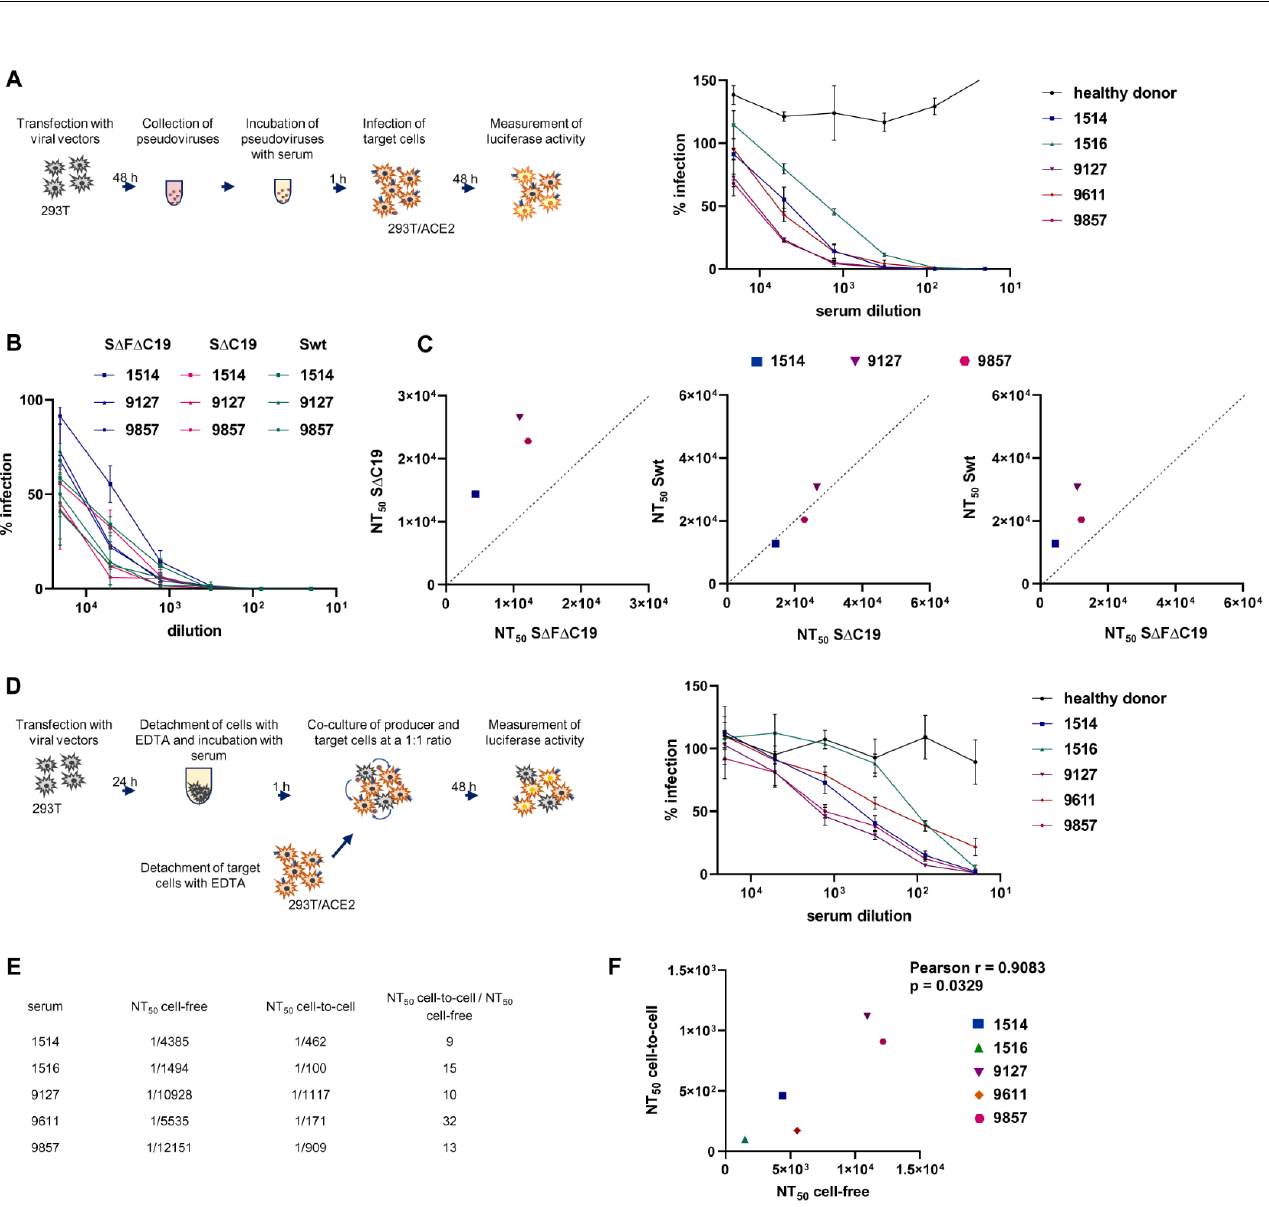
Figure 3. Neutralization activity of convalescent sera determined using SARS-CoV-2 PVs. ( A ) The experimental steps designed for the cell-free neutralization test. Viral particles pseudotyped with ΔFΔC19 were preincubated with human serum dilution for 1 h and added to the 293T/ACE2 target cells. The control RLU values obtained without serum were set at 100%. The levels of infection detected in the presence of immune or non-immune serum were presented relative to control. ( B ) Neutralizing activity of convalescent sera against wild-type and two indicated S protein mutants measured in a cell-free infection test. The assay was set up as in ( A ). ( C ) Correlations between 50% serum-neutralizing titers (NT 50 ) calculated for SΔFΔC19-PVs, SΔC19-PVs, and Swt-PVs. ( D ) A schematic illustrating cell coculture neutralization assay setup (on the left) and neutralization curves (on the right) obtained for indicated sera in this test. 293T cells transfected with viral vectors for 24 hours were detached with 1 mM EDTA, incubated with a serially diluted serum for 1 h, and cocultured with 293T/ACE2 cells at 1:2 ratio for 48h. Data were collected and presented as in ( A ). The average results from three independent experiments ± standard deviations are shown in ( A , B , D ). ( E ) Comparison of the 50% serum-neutralizing titers (NT 50 ) obtained in cell-free and cell coculture infection tests with PVs. The values were extracted from data presented in ( A , D ). ( F ) The correlation between cell-free and cell coculture neutralizing titers detected for five convalescent